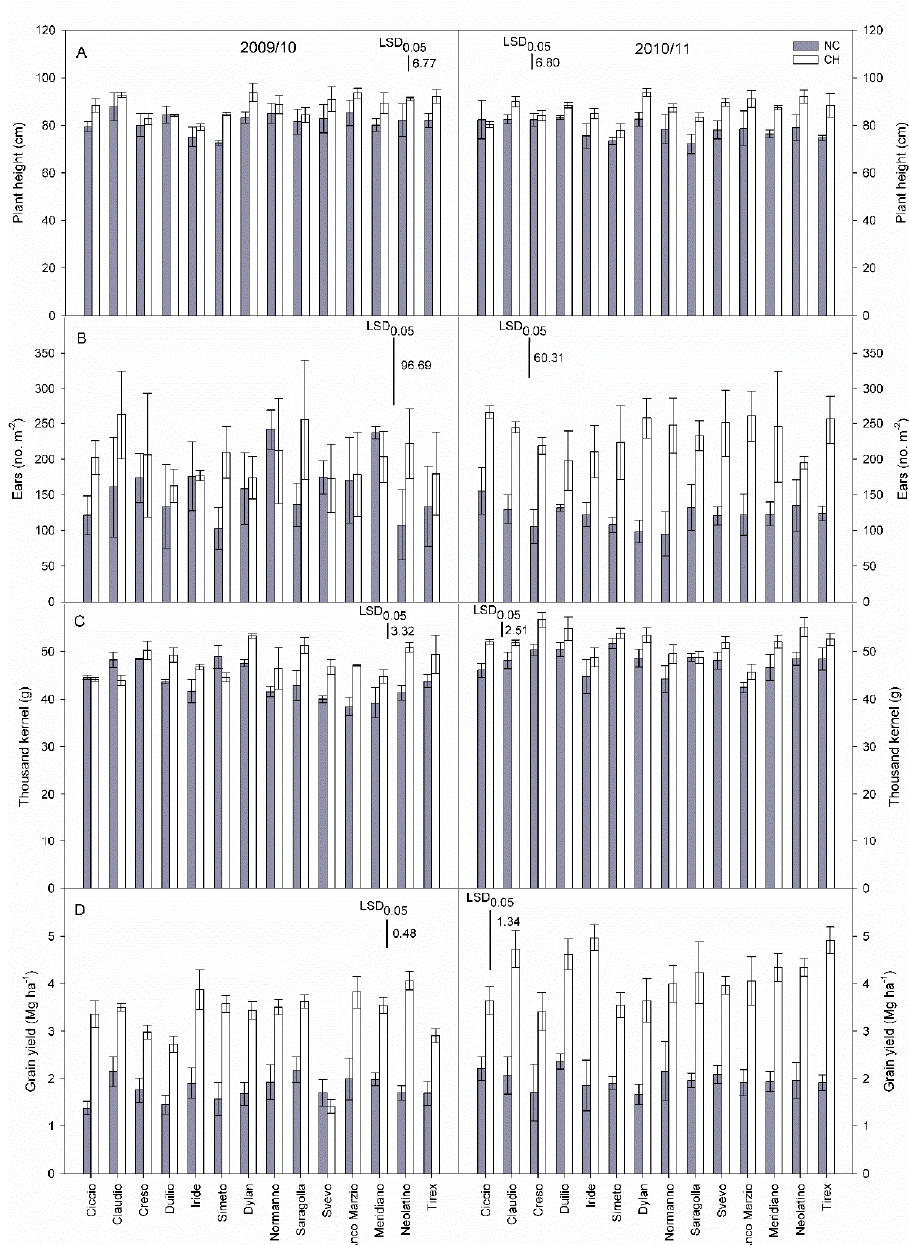
Figure 3. Morphological and productive traits of durum wheat genotypes under conventional and no-chemical input management systems in two growing seasons (2009 / 10 and 2010 / 11). ( A ) Plant height (cm); ( B ) Ears (no m − 2 ); ( C ) Thousand kernel (g); ( D ) Grain yield (Mg ha − 1 ). Vertical line “genotype × management system” interaction per p ≤ 0.05 (LSD 0.05 ).